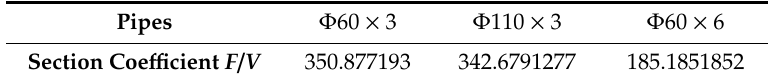
Table 3. Bar section coe ffi cient.